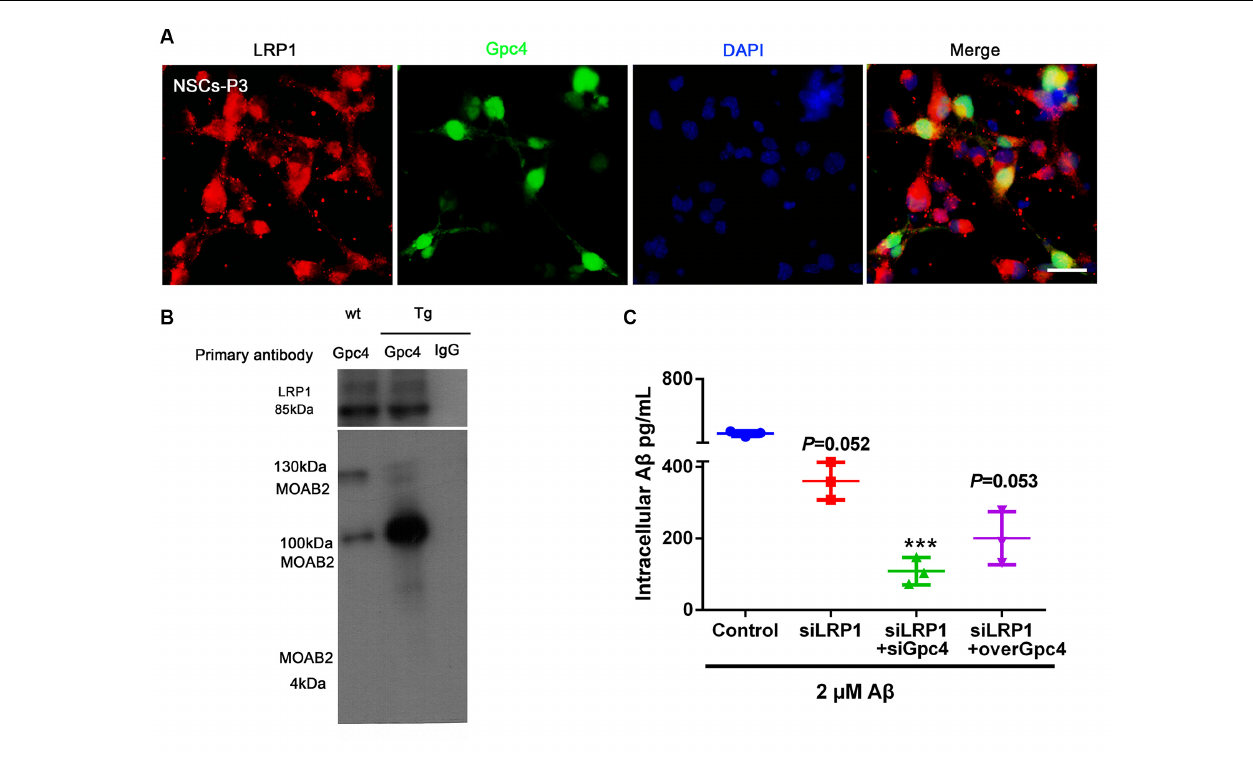
FIGURE 6 | Gpc4 regulates A β internalization partially via LRP1 in NSCs. (A) Immunofluorescence revealed LRP1 (red) abundantly colocalized with Gpc4 (green) in NSCs. Nuclei were counterstained with DAPI (blue), scale bar = 20 µ m. (B) Co-immunoprecipitation result from protein lysis extracted from 6-month-old APP/PS1 mice. Protein samples were incubated with primary antibody Gpc4. Protein complexes able to bind to Gpc4 were then eluted. Western blotting was used to detect the MOAB2- (A β 42) and LRP1-positive binds. (C) Seventy-two hours after adenovirus transfection, 2 µ M A β 42 was added to the control, siLRP1, siLRP1 + siGpc4, and siLRP1 + overGpc4 groups. The levels of A β 42 were detected using ELISA. *** represents siLRP1 + 2 µ M A β vs. siGpc4 + siLRP1 + 2 µ M A β , P = 0.0011. GPc4, glypican 4; LRP1, low-density lipoprotein receptor related protein 1; NSCs, neural stem cells; DAPI, 4 (cid:48) ,6-diamidino-2-phenylindole; ELISA, enzyme-linked immunosorbent